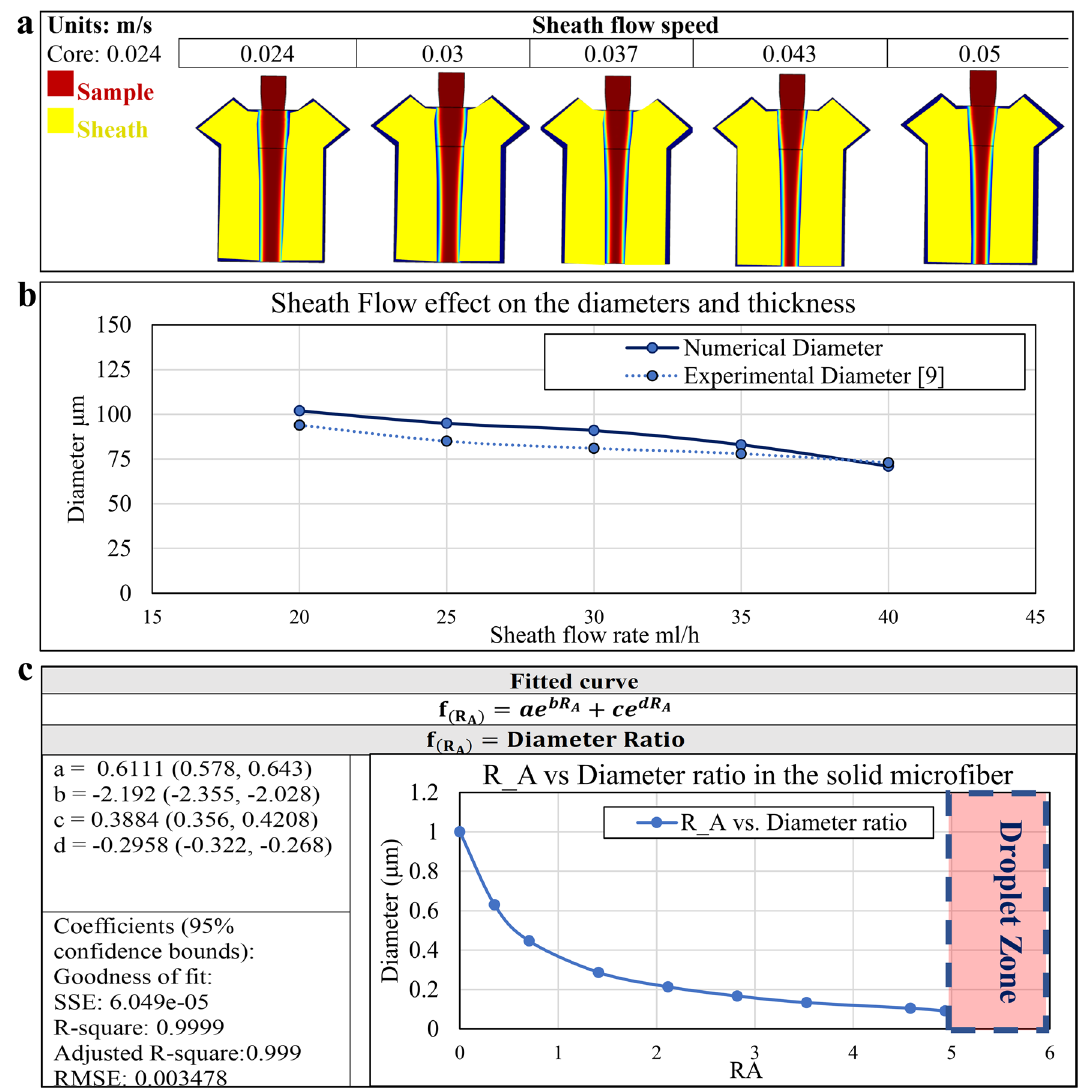
Figure 6. Solid microfiber generation using MBP ( a ) The phase boundary field output of the calcium alginate solid microfiber fabricated inside the microfluidic channel based on different sheath flow rate, ( b ) The comparison of the experimental and numerical diameter of the solid microfiber3 ( c ) The prediction equation of solid diameter ratio and wall thickness ratio based on R B and R A